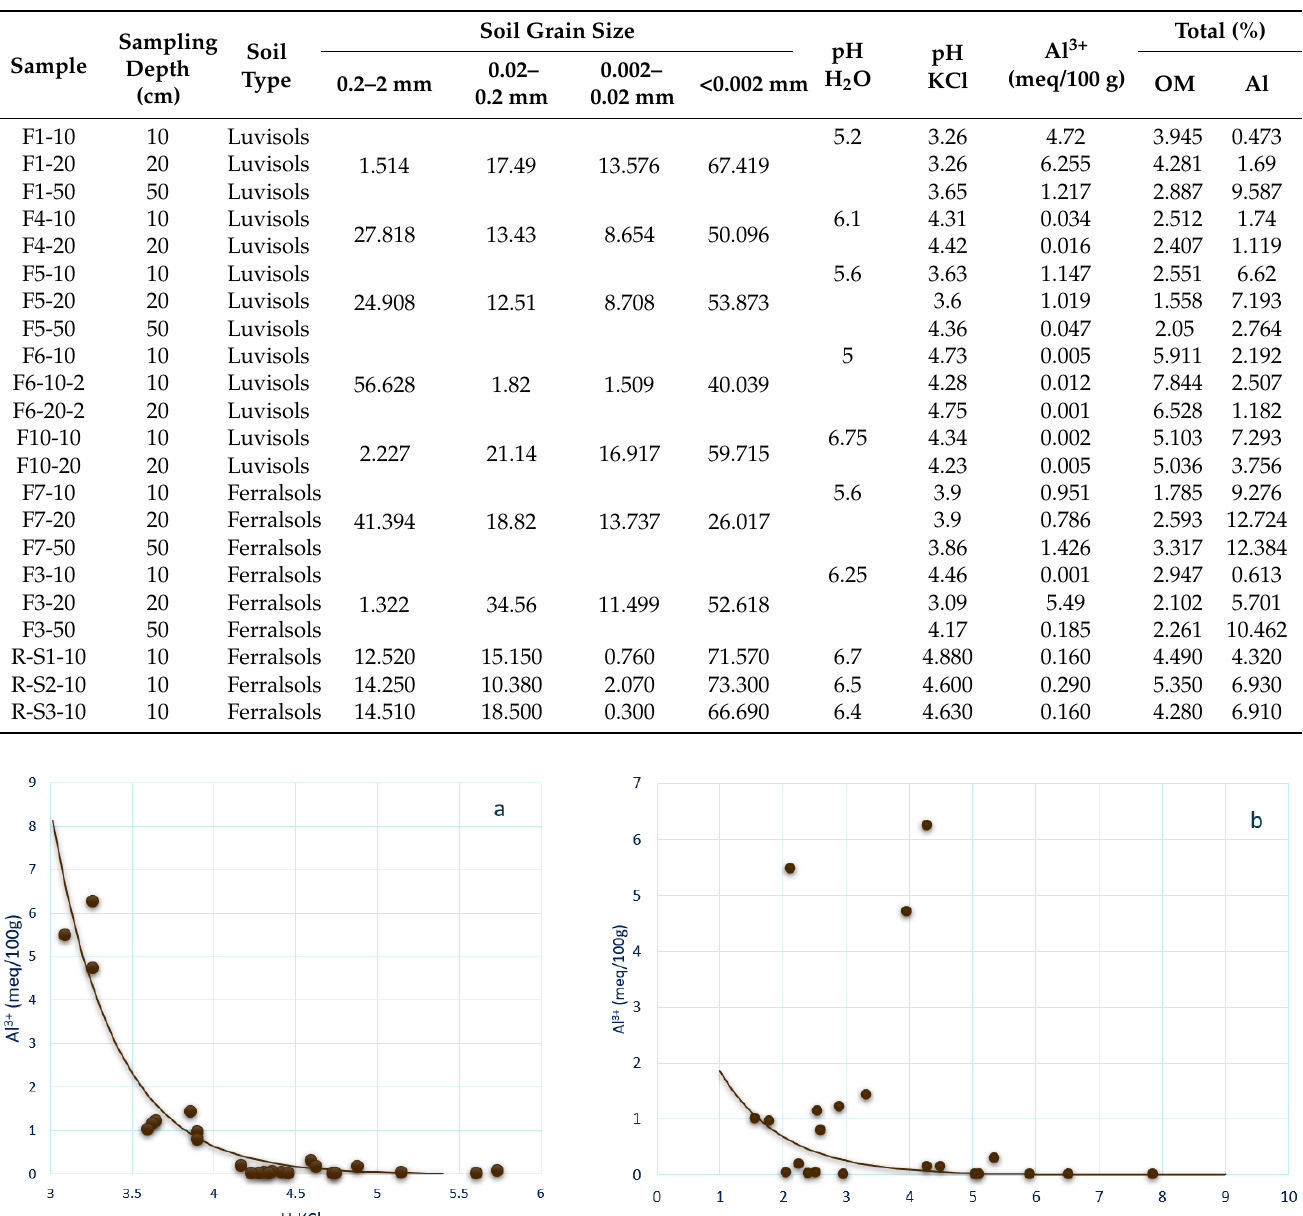
Table 1. Soil characteristics at sampling positions. These data are used for maps validation.